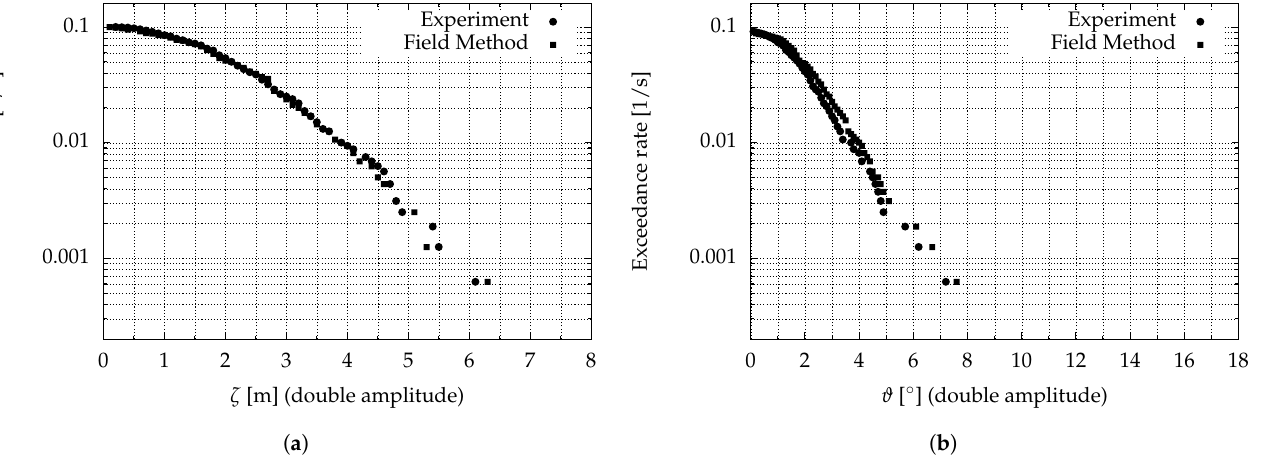
Figure 27. Containership: short-term statistics of ( a ) heave and ( b ) pitch motions.